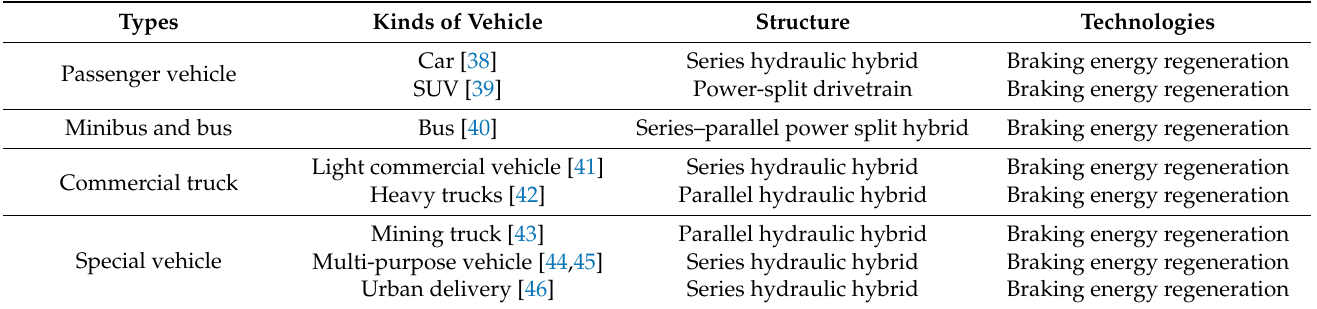
Table 1. Types, kinds, structures and technologies of hydraulic hybrid vehicles.